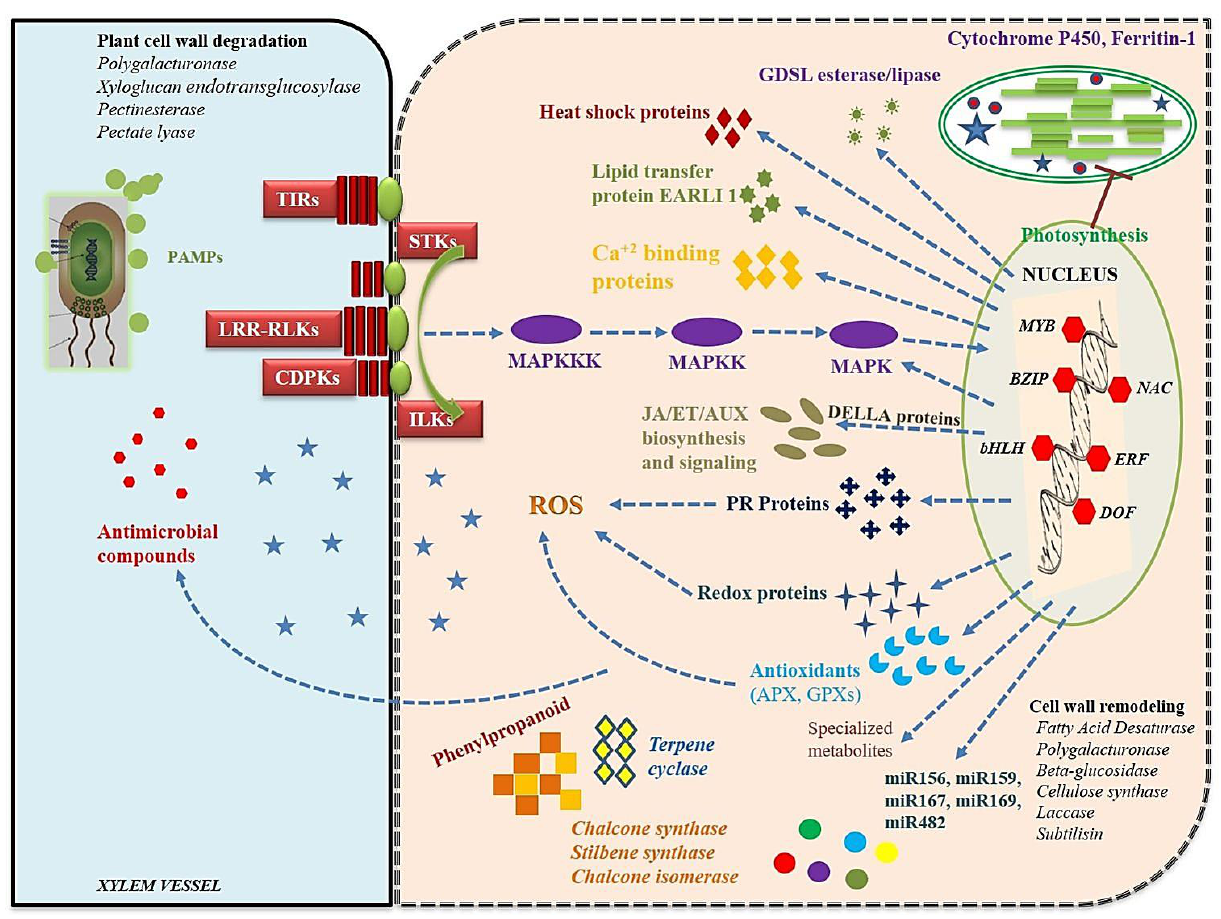
Figure 8. The molecular network operating in L. culinaris when infected with R. bataticola . Comparative transcriptomic analysis has shown the perception of fungus by lentil root cells resulting in the degradation of the cell wall and its establishment by taking control over the host defense. Where,